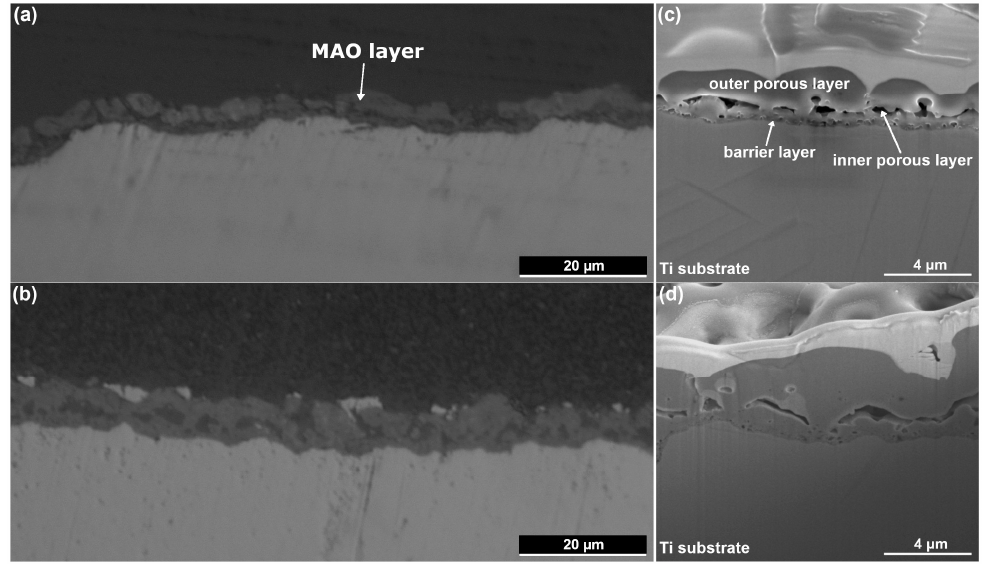
Figure 2. Cross-sectional OM, and FIB prepared cross-sectional SE/SEM images of ( a , c ) 015CA and ( b , d ) 035CA samples, respectively. ( b , d ) 035CA samples,